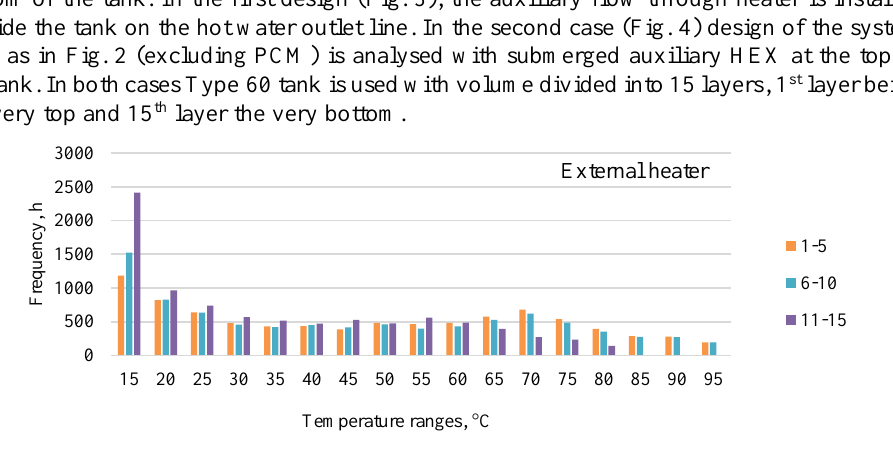
Fig. 3. Hourly frequency of temperature ranges with external flow-through heater after the tank for annual simulation.